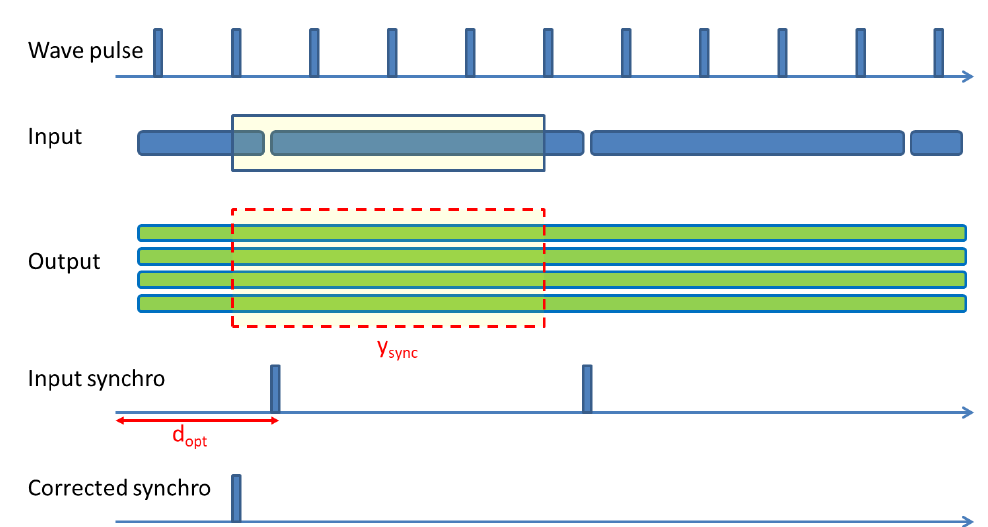
Figure 8. Synchronization between input signal, modulating waveforms and MWC outputs.